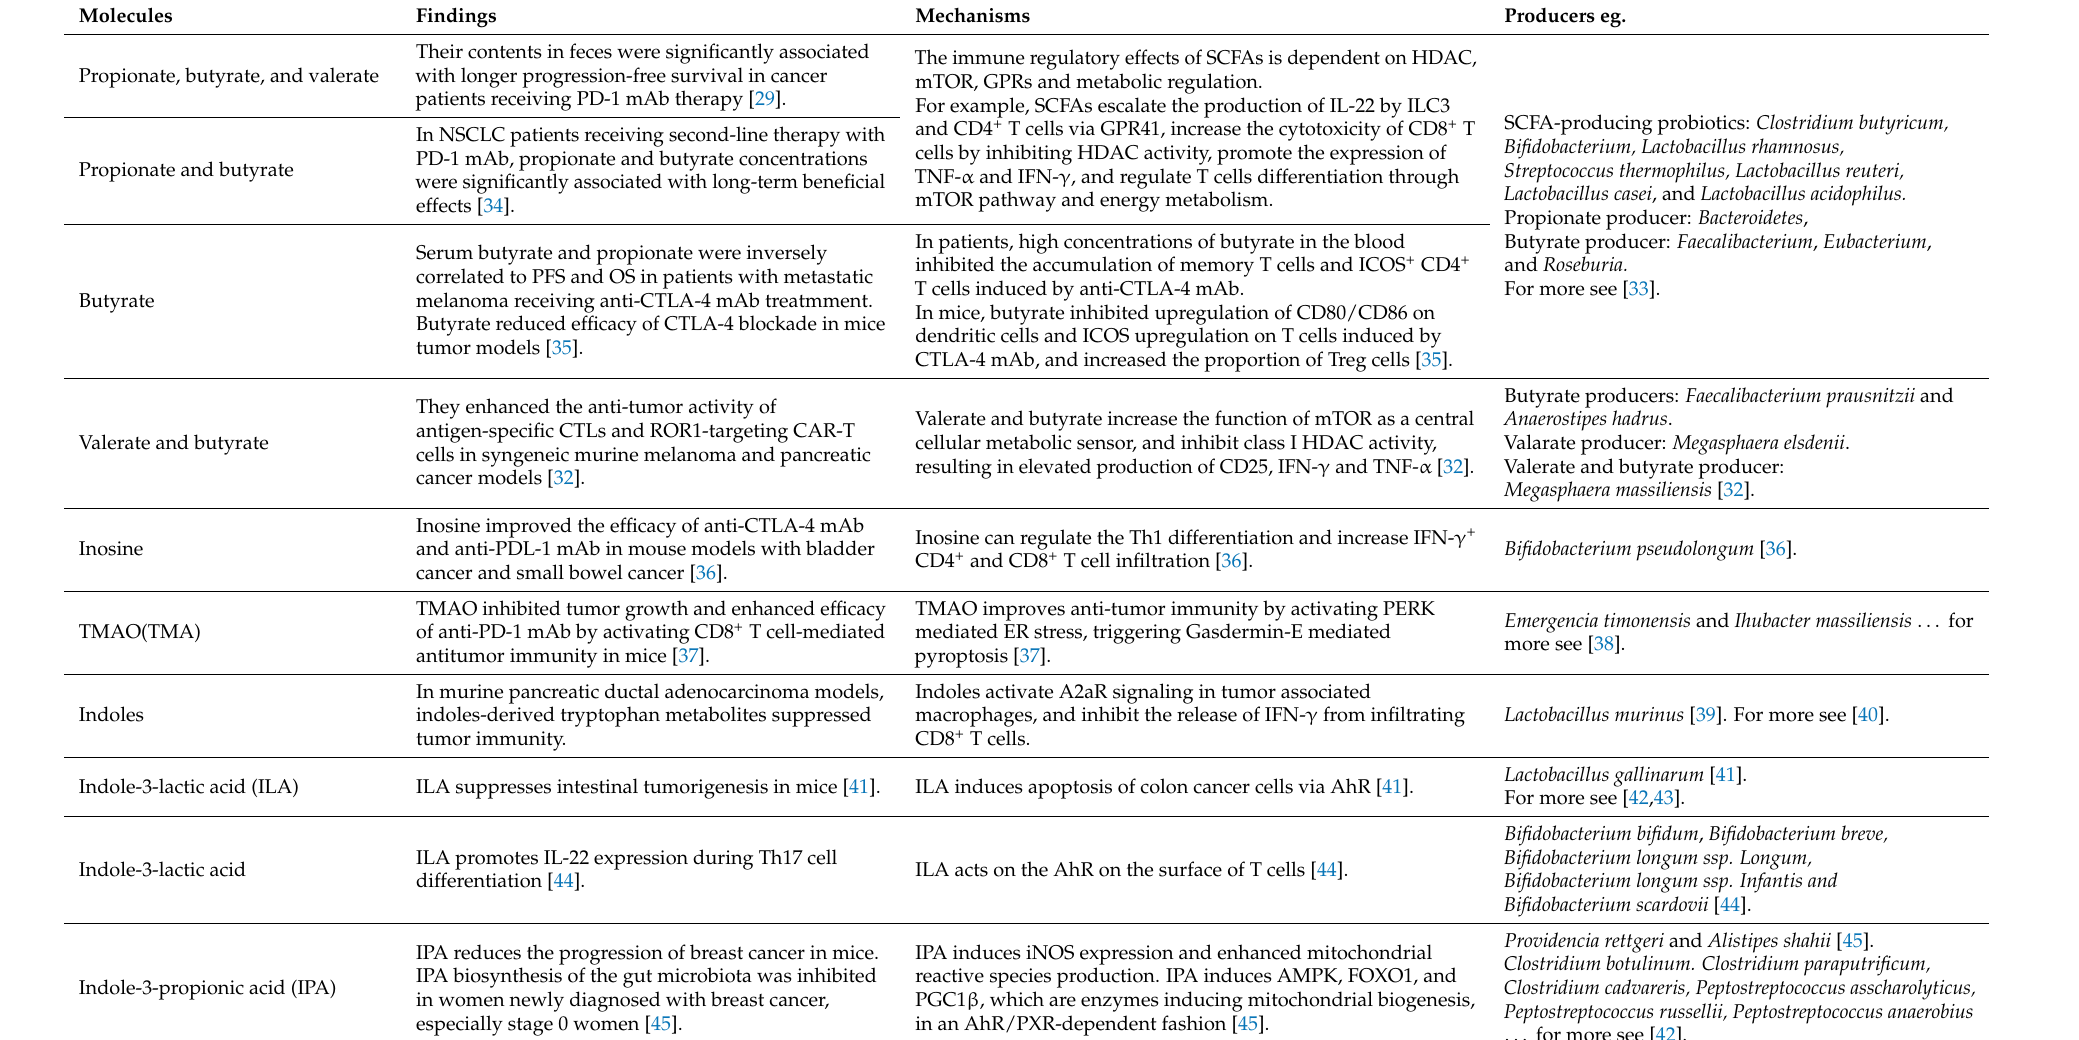
Table 1. Findings, mechanisms and producers of